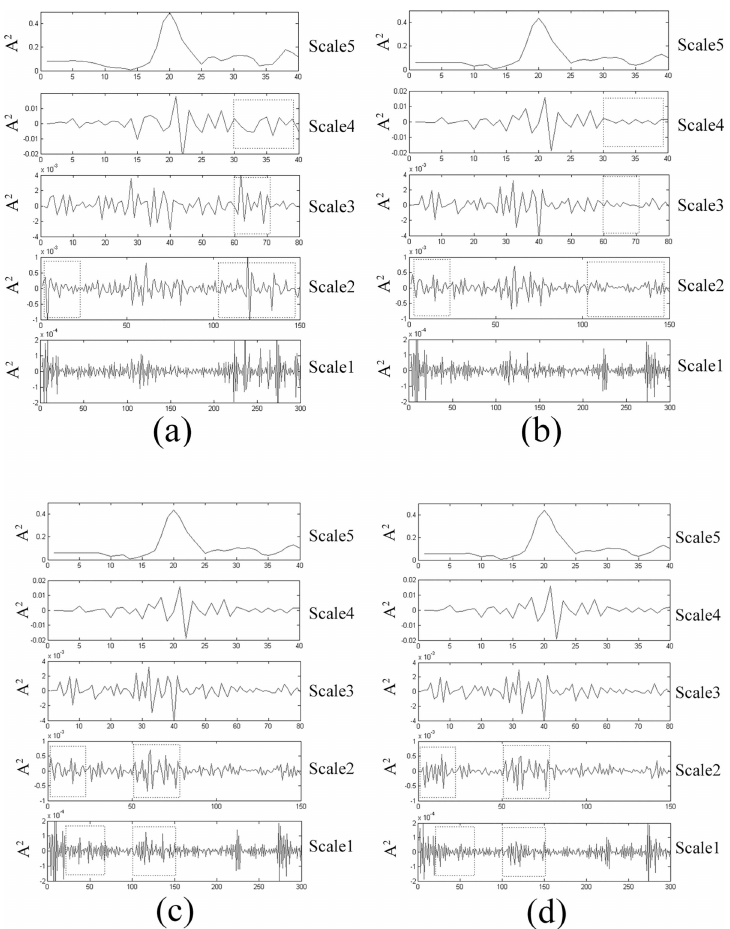
Fig 6. Results of the Multi-Resolution Decomposition for the FTIR Spectra with DWT. Rhodobryum roseum collectedfrom different areas (a): Rhodobryum roseum 1; (b): Rhodobryum roseum 2; Two Replicatesof Rhodobryum roseum ; (c): Rhodobryum roseum 2.1; (d): Rhodobryum roseum